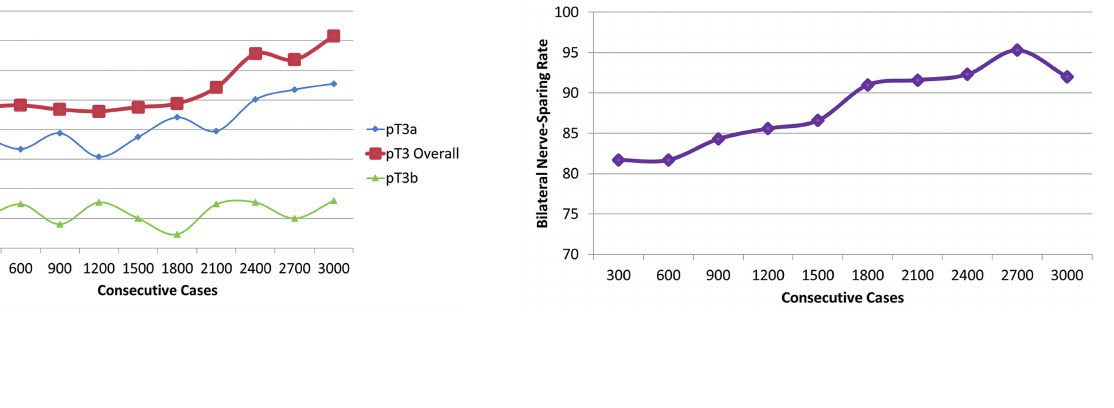
figure 3 - Rates of positive surgical margins in 3000 consecutive patients undergoing open radical retropubic prostatectomy by a single surgeon